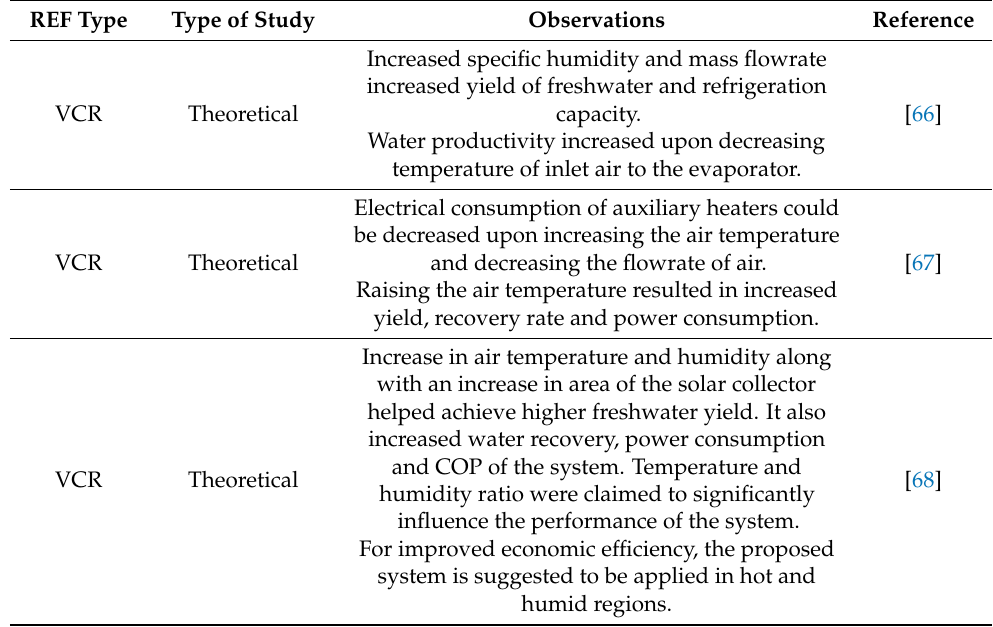
Table 1. Observations from various HDH–REF